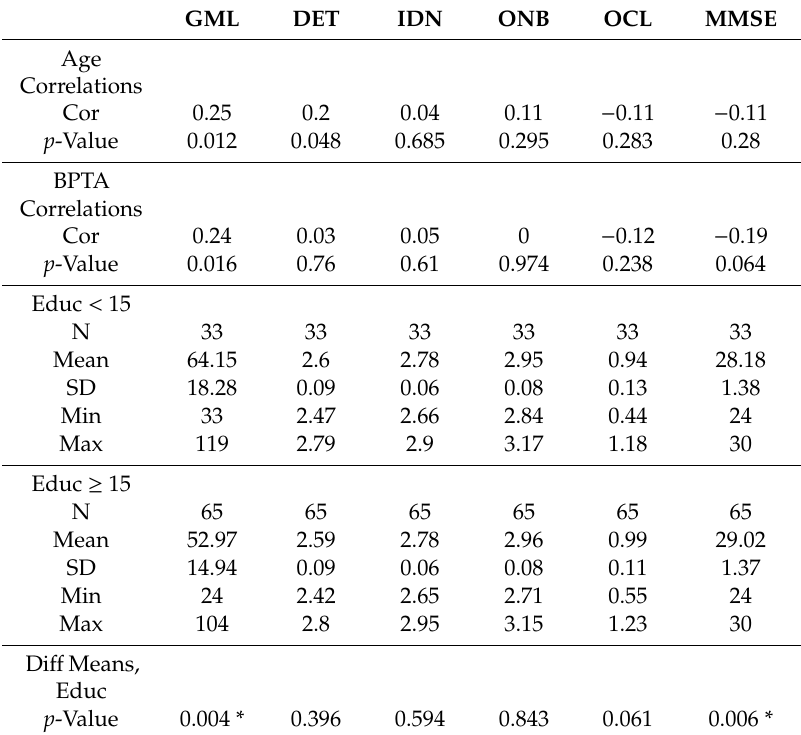
Table 4. Pairwise associations of cognitive performance with age, hearing loss and education at